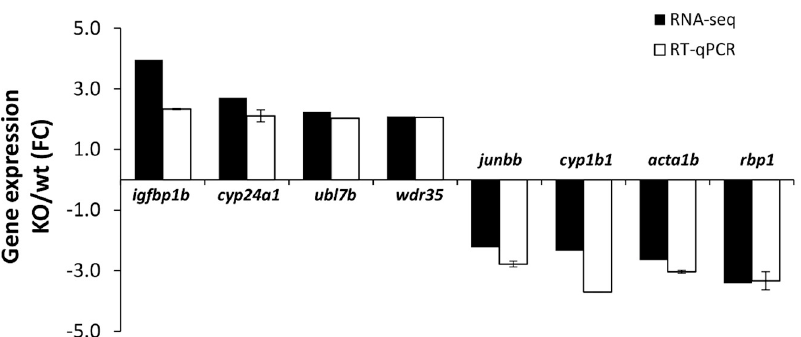
Figure 8. Confirmation by RT-qPCR of the differential expression of the selected genes identified in the RNA-seq analysis of cyp1b1 -KO zebrafish. RT-qPCR was carried out in triplicate.